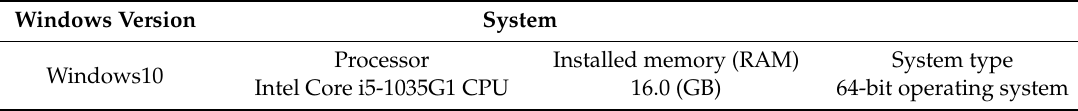
Table 2. Simulation device configuration parameters.